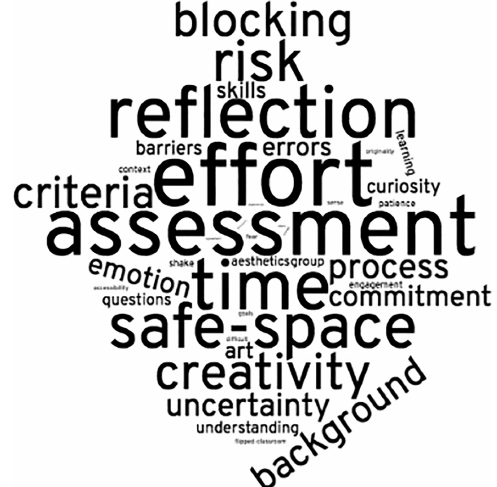
Figure 1. Graphic summary of concepts labelled and seized according to the frequency of their